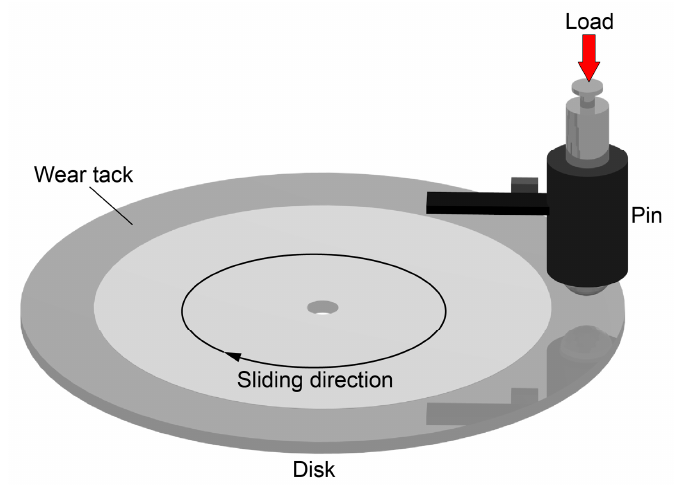
Figure 2. Schematic representation of the pin on disk tests. In particular, the pin is pressed against a rotating disk under the given load. The pin can be of any shape; however, the most popular shapes are spherical or cylindrical.